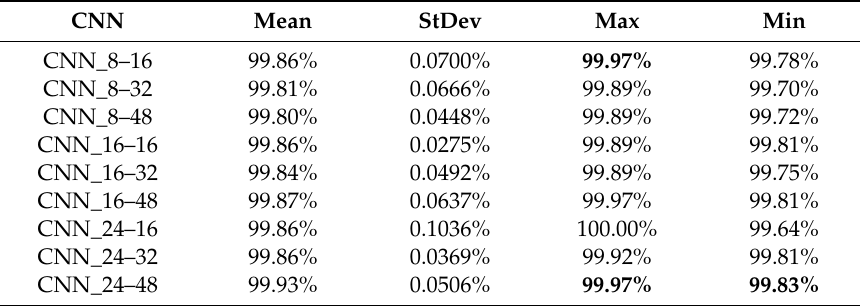
Table 4. Results of CNN models with di ff erent number of